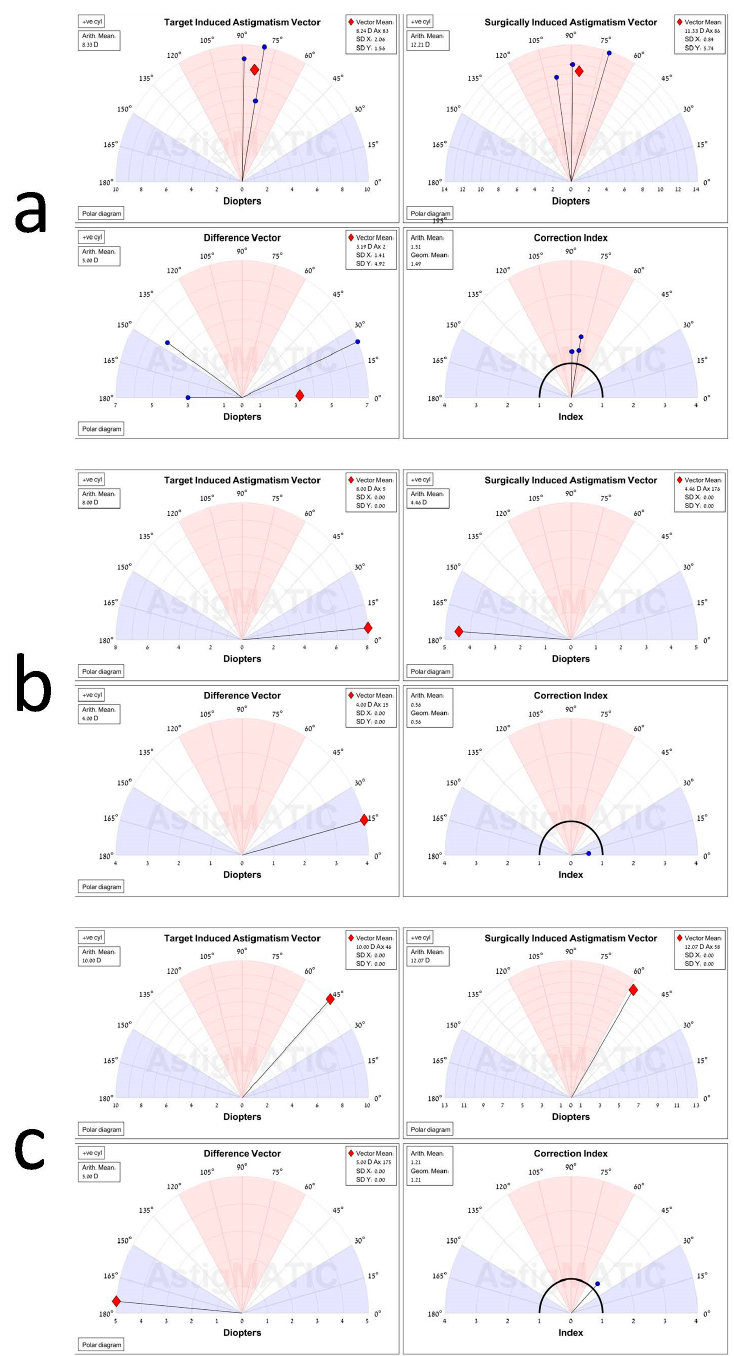
Figure 2. Printout results of the AstigMATIC software, comparing the residual astigmatism after the second astigmatic keratotomy (post-AK 2) to before the first keratotomy (pre-AK 1) on five patients: ( a ) Three patients exhibiting with-the-rule astigmatism. ( b ) One patient with against-the-rule astigmatism and ( c ) one patient with oblique astigmatism. The magnitude and axis of astigmatism